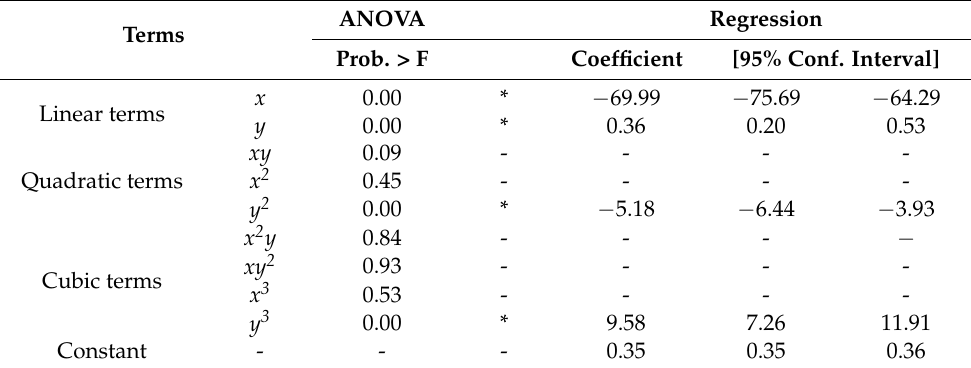
Table 8. Results of analysis of variance (ANOVA) and regression with cubic polynomial.